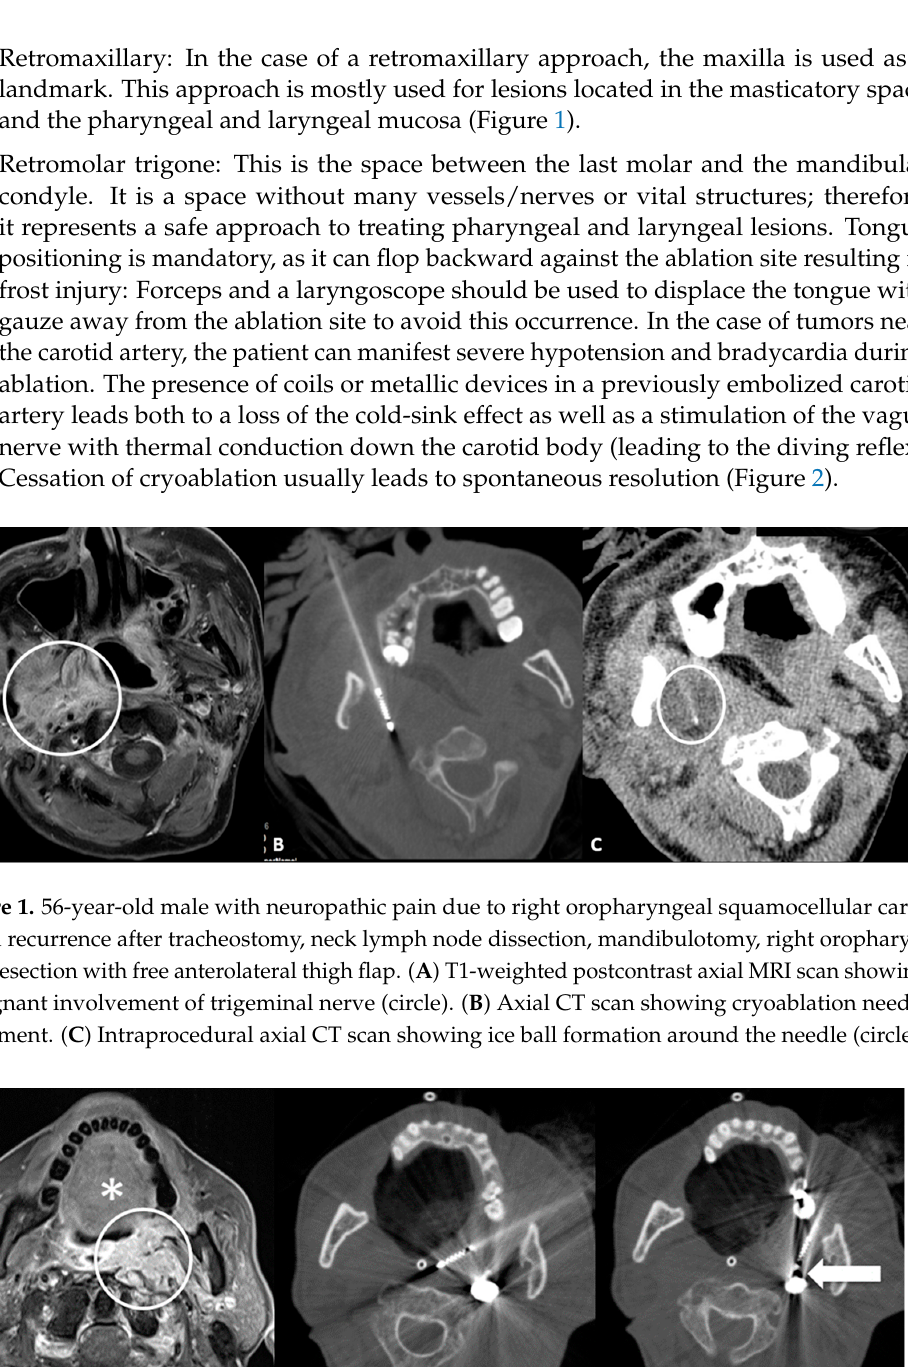
Figure 3. 63-year-old male with recurrence of supraglottic squamocellular carcinoma which under- went previous total pharyngolaryngectomy and bilateral neck dissection. ( A ) T1-weighted unen- hanced axial MRI scan showing the tumor recurrence (X), the mucosa of the neopharynx (arrow),